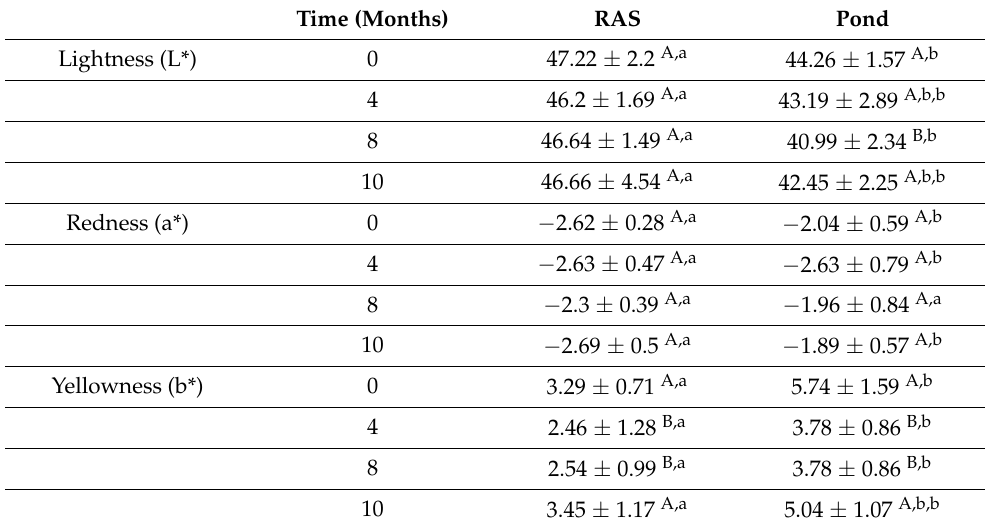
Table 4. Color changes in fish fillets from RAS and pond rearing systems during 12 days of refriger- ated storage at + 4 ◦ C (mean ± S.D., n =